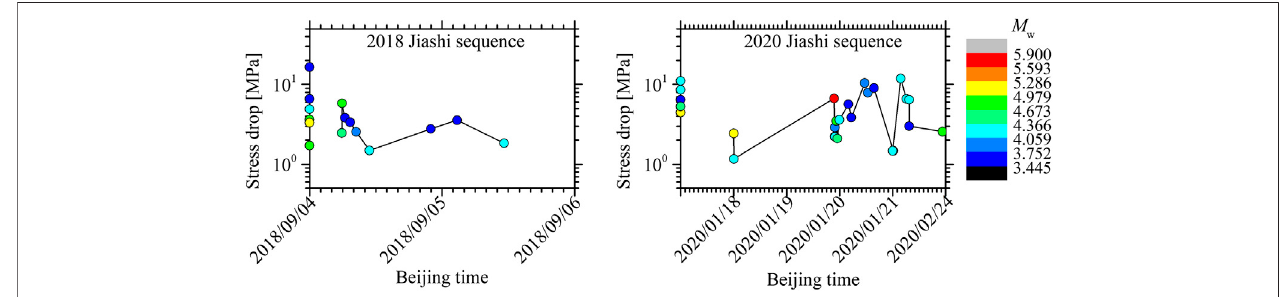
FIGURE9| Temporalvariationofstressdropsforthe2018and 2020Jiashiseismicsequences.Earthquakespreviouslyoccurring closetotheseismogenicregion are plotted in the vertical axis; #1 – #6 and #16 – #20 represent the 2018 and 2020 sequences, respectively.